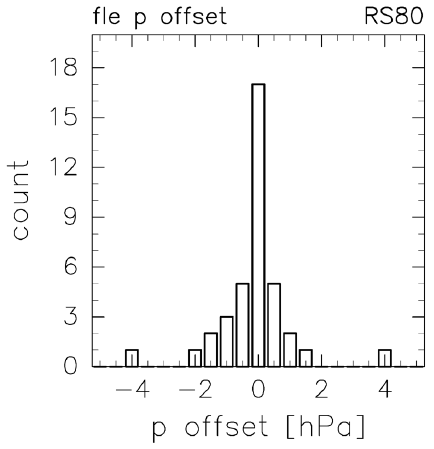
Figure A2. Frequency distribution of pressure offset, which was empirically determined using our QC procedure. The data are split into ± 0 . 25hPa bins with an increment of 0.5hPa and a total of 38 soundings.